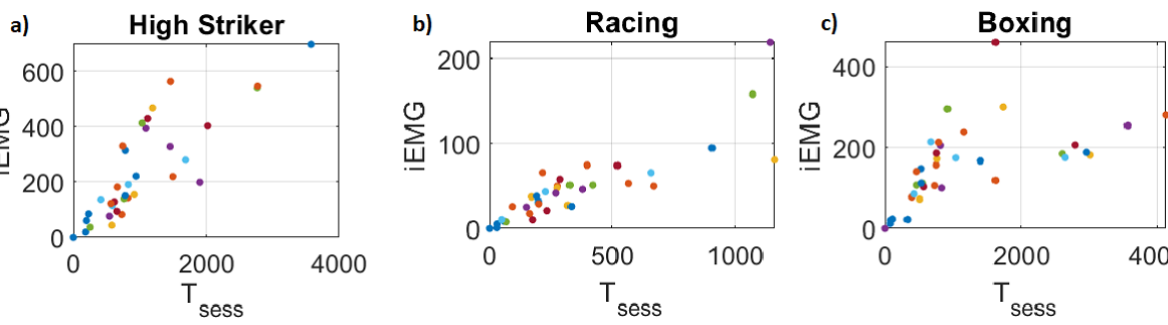
Figure 9. Scatterplots indicating the correlation between time spent on app and energy expenditure, as measured by iEMG. iEMG: integrated